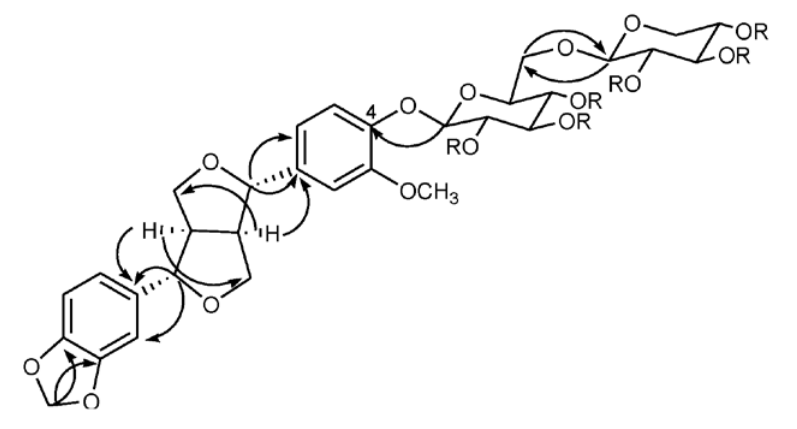
Figure 8. Key HMBC correlations of compounds 1 and 1a (Recorded on Varian